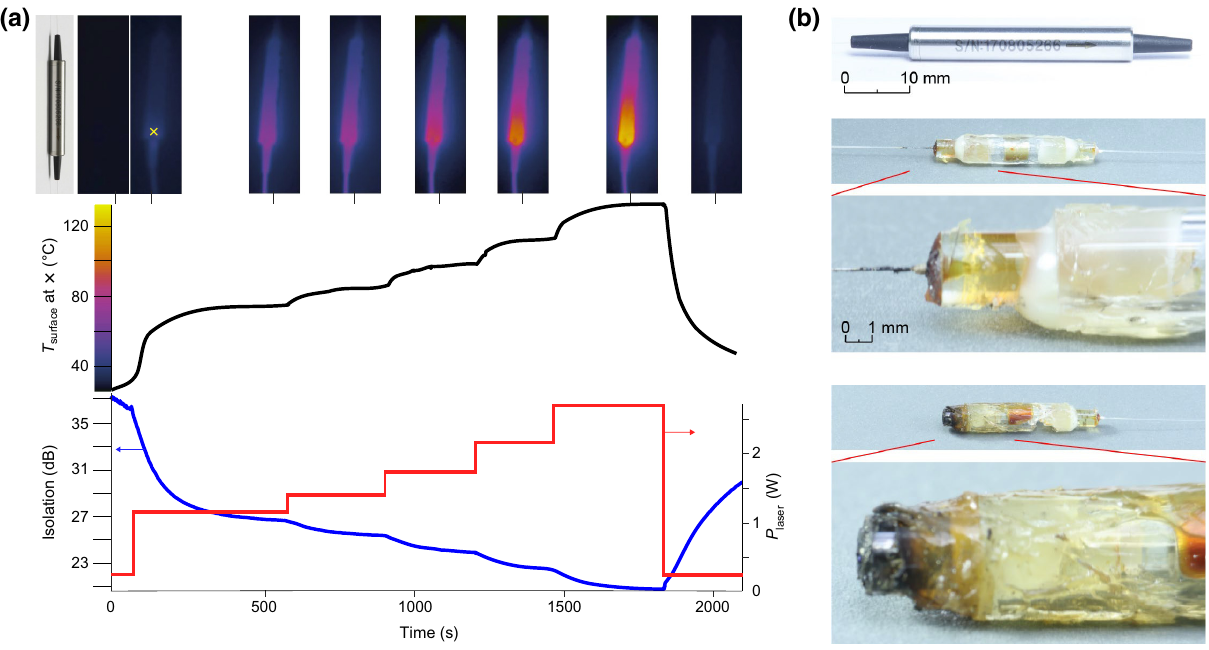
FIG. 4. Analysis of the isolator response to high-power laser exposure. (a) Isolation and temperature profile of ISO PM 2 under stepwise-increasing laser power. The temperature is measured at the hottest surface point, marked with a cross on the thermal camera images. (b) Photographs of (top to bottom) ISO 3-1 before testing, decapsulated ISO 3-1 showing its internal design (partial damage after illumination by 3.3 W is visible), and decapsulated ISO 3-2 showing damage after illumination by 3.8 W laser